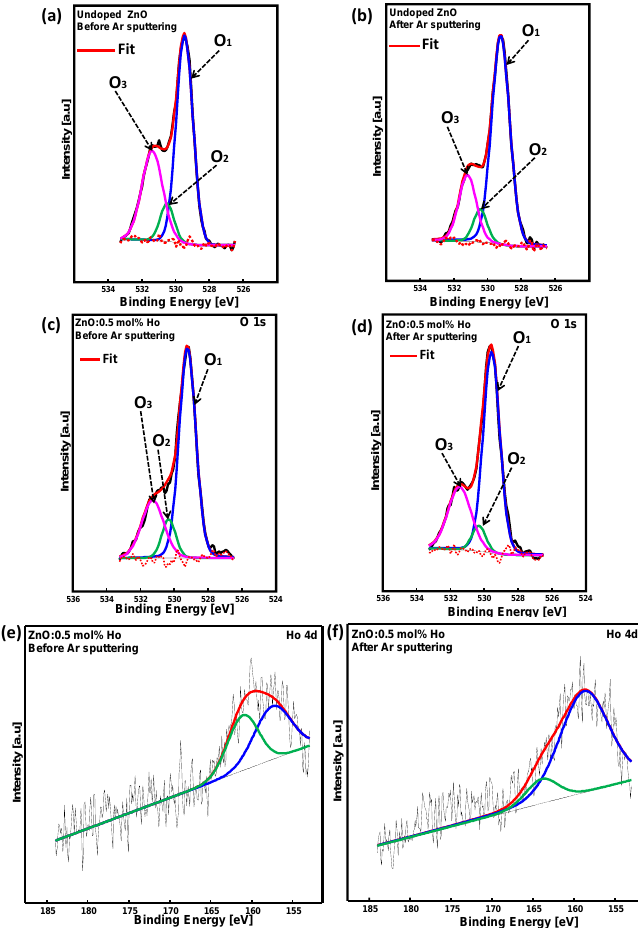
Figure 6. XPS O 1s core levels spectra for un-doped ZnO ( a ) before and ( b ) after Ar + sputtering and 0.5 mol% Ho 3+ -doped ZnO ( c ) before and ( d ) after Ar + sputtering. XPS Ho 4d core levels ( e ) before and ( f ) after Ar + sputtering.